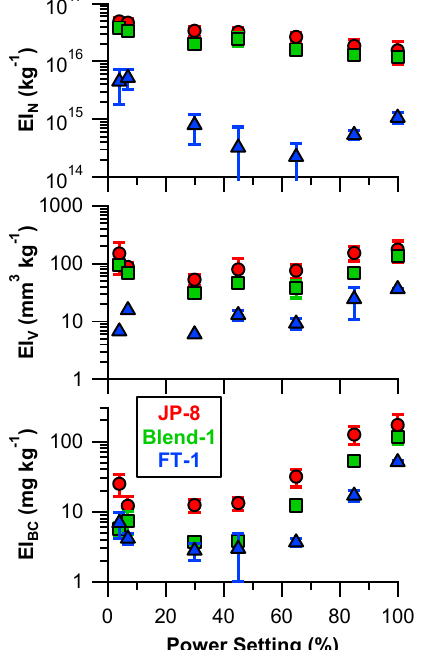
Fig. 12. Emission indices for JP-8, Blend-1, and FT-1 fuel at 30m behind the engine plane. Data are solely from the #3 engine. One- sigma standard deviations are shown as error bars. EI N and EI V uncertainties are frequently below the figure